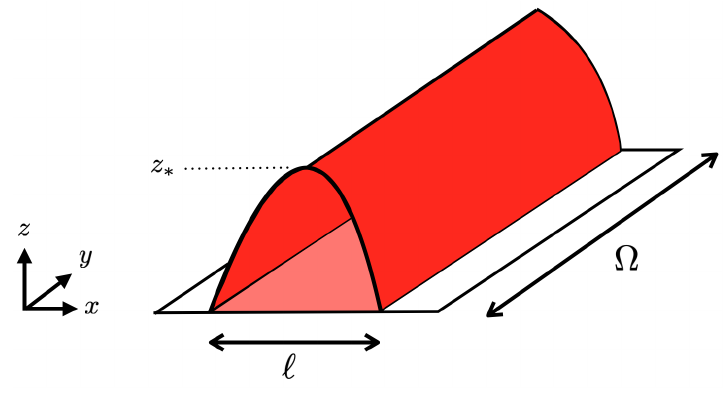
Figure 2 . A strip entangling region with its minimal surface (red). The strip has width ‘ in the x -direction and length Ω in the y -direction. z ∗ is the largest z value of the minimal surface in the